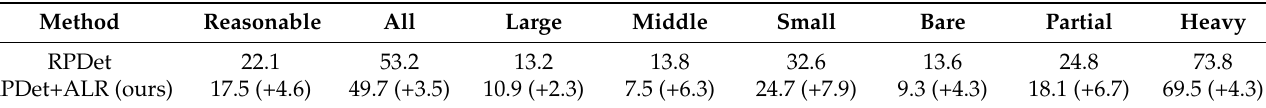
Table 2. Comparison of RPDet+ALR with baseline across each subset of the CityPersons validation set (MR − 2 /%).